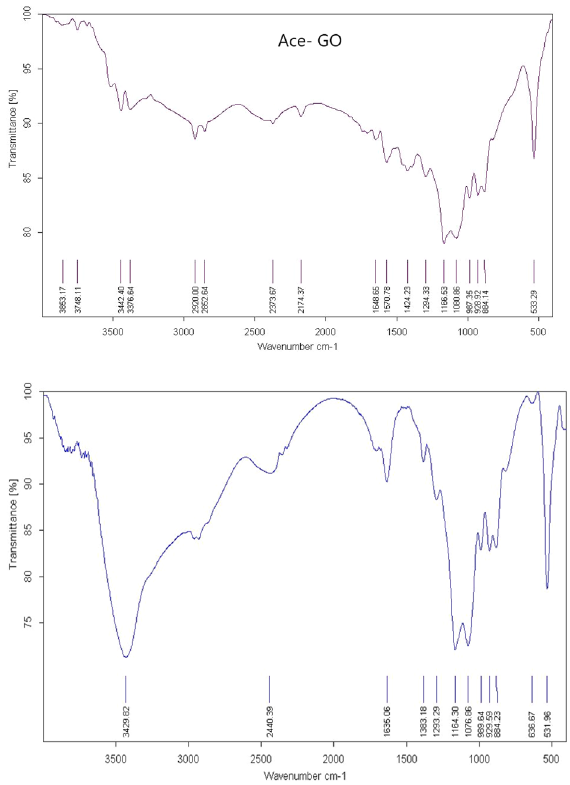
Figure 6. IR Spectrum of Acetamiprid-graphite